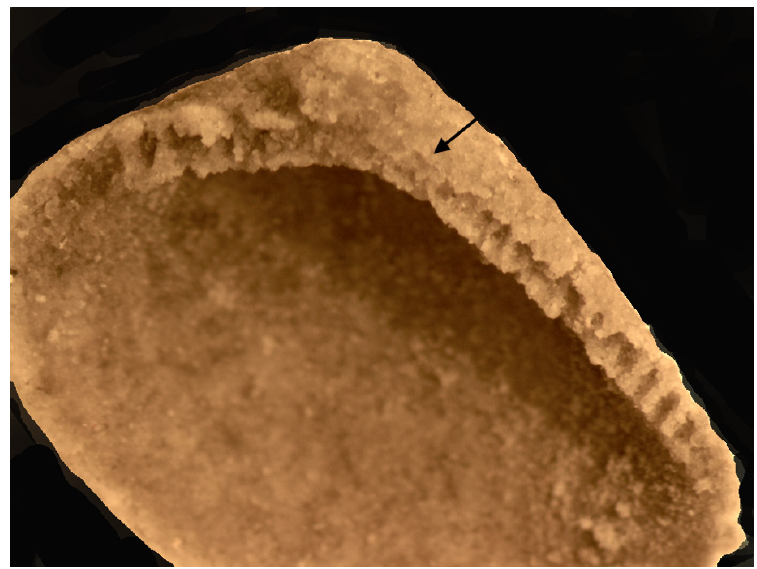
Figure 5. Nuculanoid clam fossil (IGM 5010a). Close up image of the hinge area, showing external ligament groove (arrow).